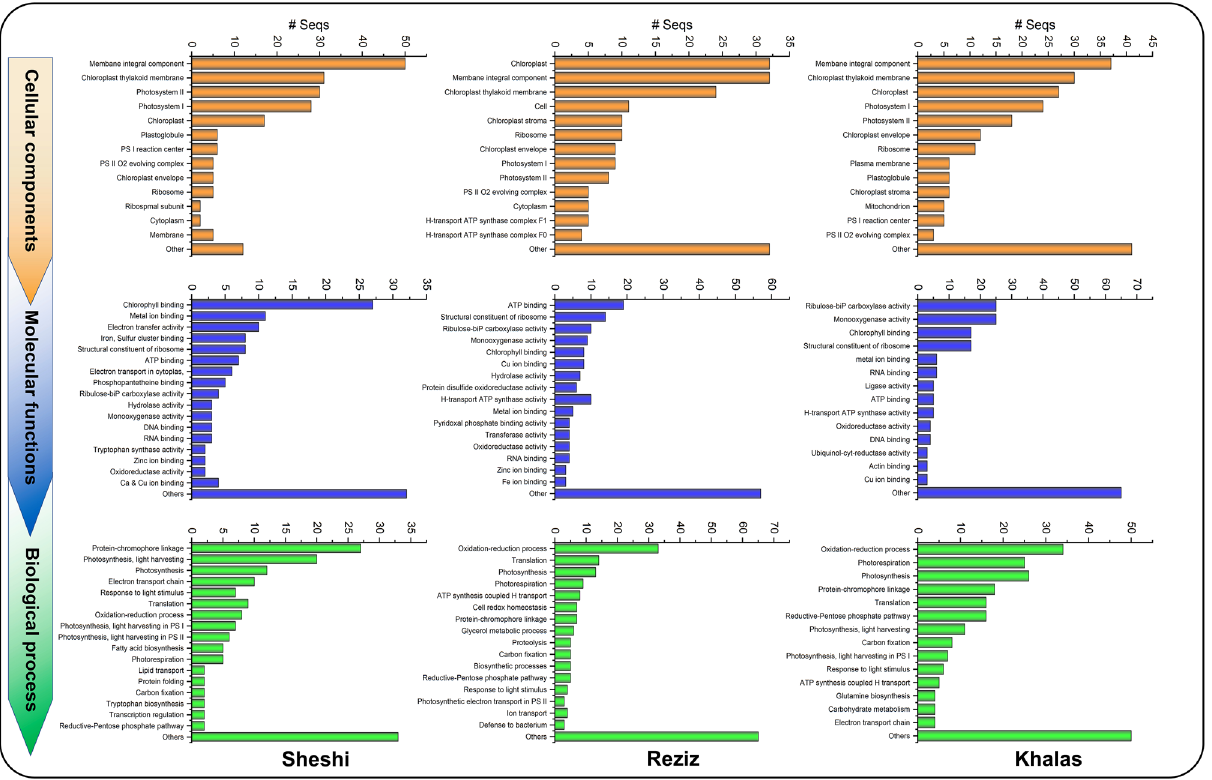
Figure 3. Relative comparative gene ontology (GO) of drought-responsive ESTs in three date palm cultivars. GO terms were organized contingent on p values ≤ 0.05. The x-axis showed activities to which ESTs belong to cellular components, molecular functions, and